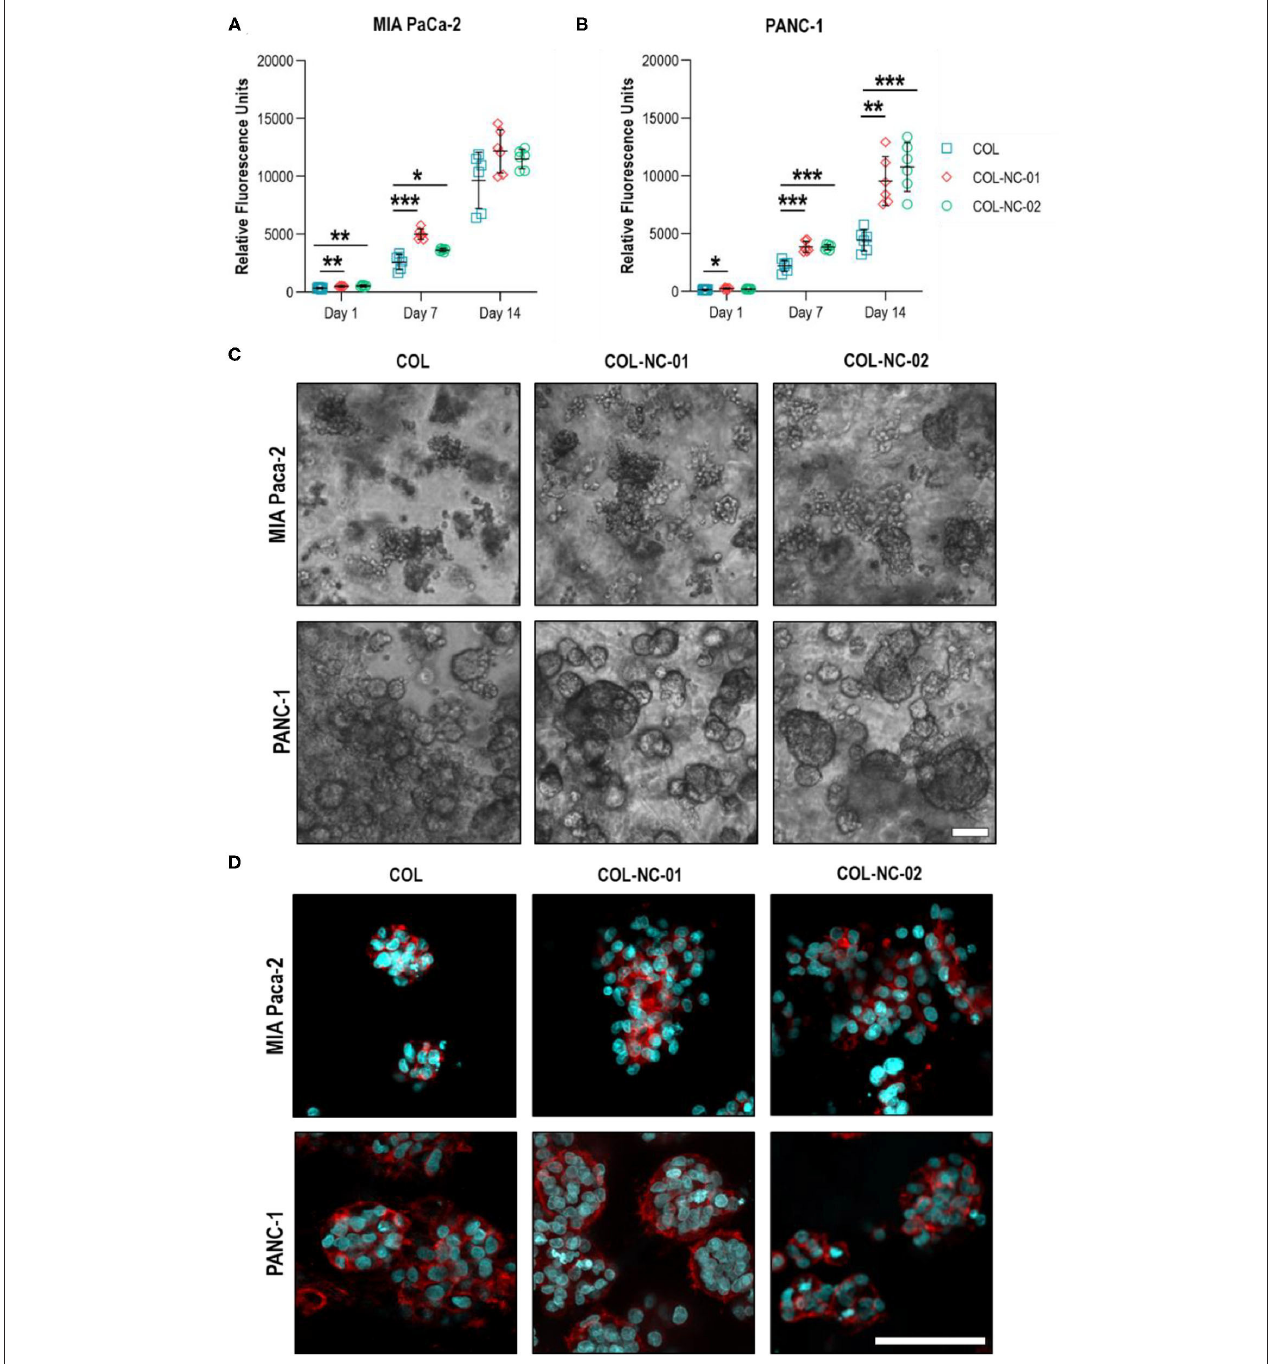
FIGURE 3 | Proliferation and morphology of spheroids formed by PDAC cells. The metabolic activity of MIA PaCa-2 (A) and PANC-1 (B) cells grown in collagen and collagen-nanocellulose hydrogels progressively increased over the 14 days culture period. (C) MIA PaCa-2 cells formed irregular clusters within all hydrogels tested, while PANC-1 cells formed round spheroids with larger diameters with increasing nanocellulose concentration. Scale bar = 100 µ m. (D) Confocal micrographs of F - actin filaments (red) and nuclei (blue) of MIA PaCa-2 and PANC-1 cells in 3D culture. Scale bar = 50 µ m. Results shown represent independent experiments performed in triplicates ( n = 3, error bars = SD; * = p ≤ 0.05; ** = p ≤ 0.01; *** = p ≤ 0.001). COL, collagen; NC, nanocellulose; COL-NC-01, collagen-nanocellulose at 0.1 wt%; COL-NC-02, collagen-nanocellulose at 0.2 wt%.